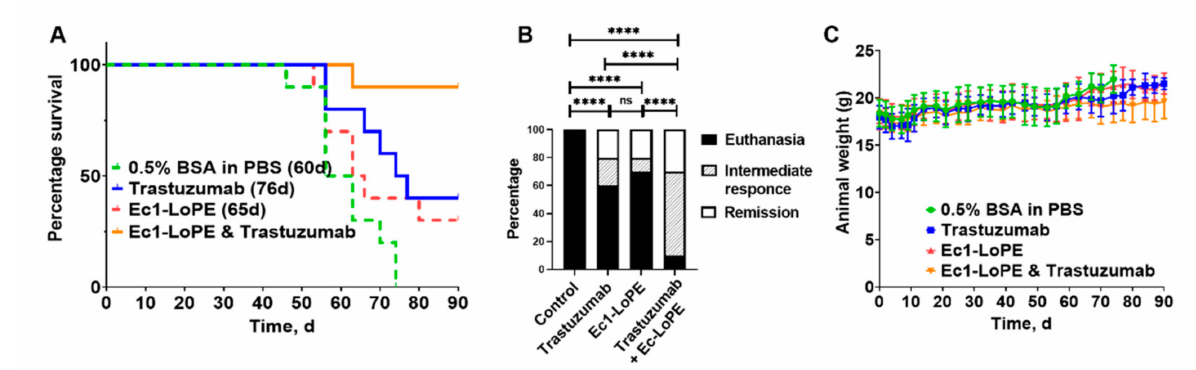
Figure 9. Antitumor effect of monotherapies using Ec1-LoPE or trastuzumab and their combination in female BALB/c nu/nu mice bearing EpCAM- and HER2-expressing SKOV3 xenografts. Four groups of mice (10 animals per group) were used in the experiment. ( A ) Survival of mice during the experiment. ( B ) Therapy outcomes for different treatment groups. The outputs categories were defined as euthanasia (animal reached humane endpoint before the study termination), intermediate response (macroscopic tumors at the study termination), and remission (no tumors at the study termination). The difference between groups was determined using chi-square test. Symbol **** corresponds to p < 0.0001. ( C ) Average animal